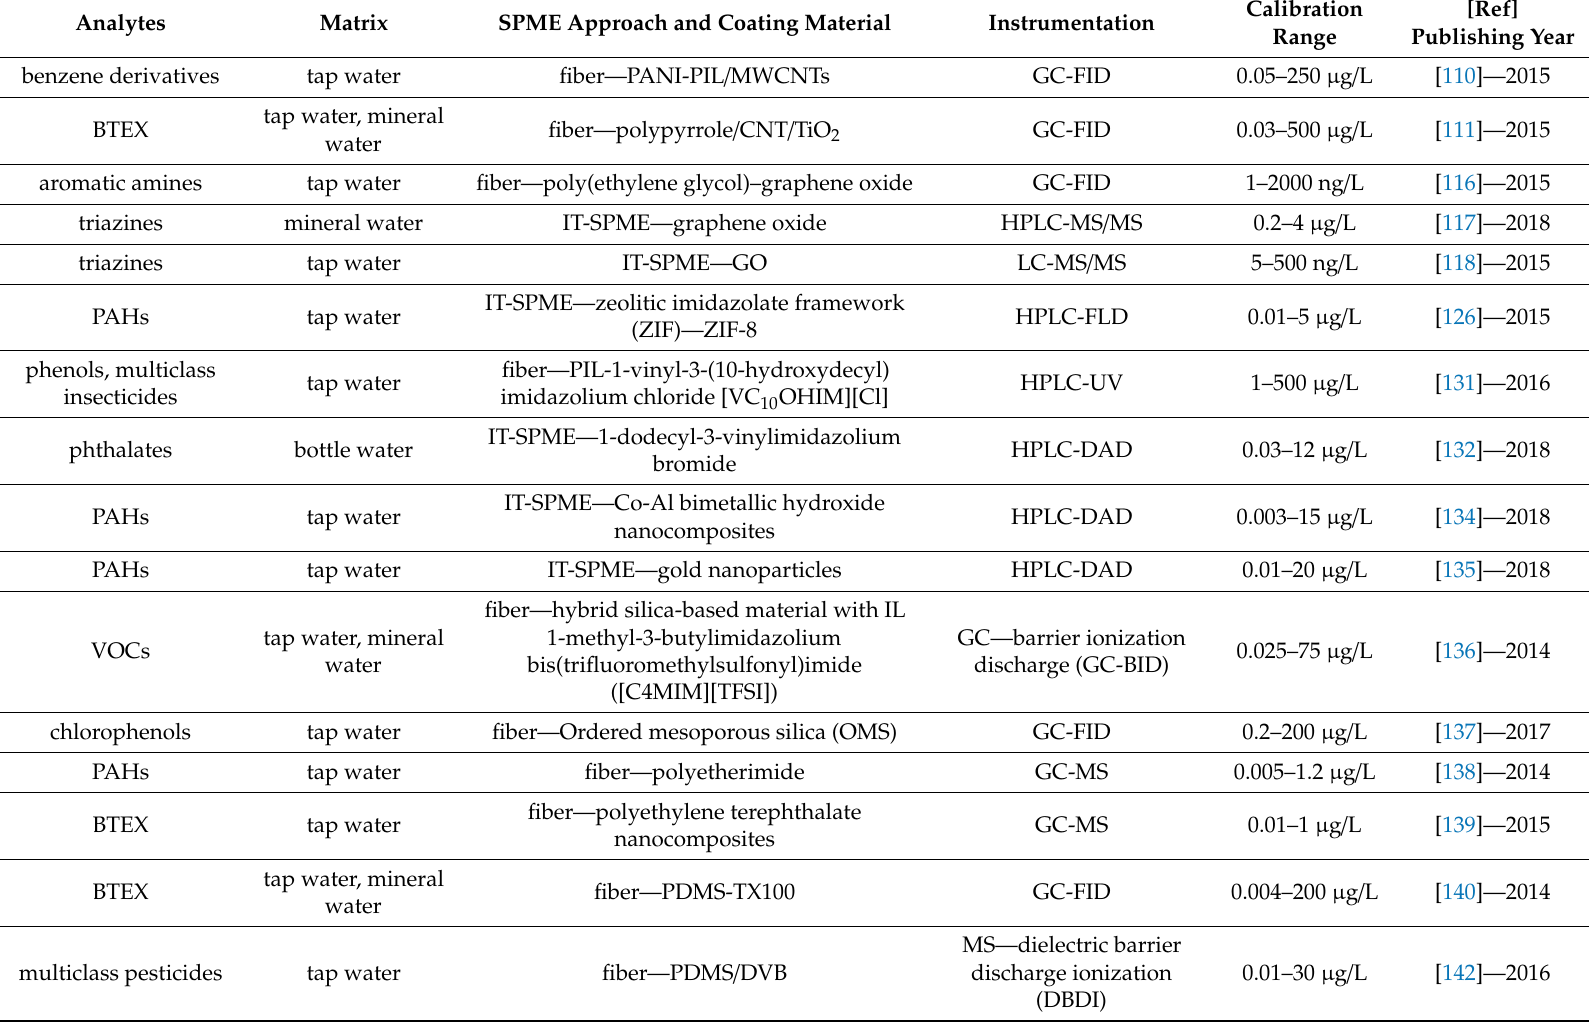
Table 2. Selected SPME applications in food